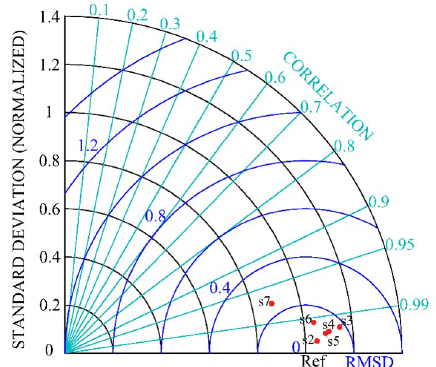
Figure 29. Taylor diagram of hydrodynamic pressures at x = 10m and z = 2 . 1m, taking as reference the data series of the finest reso- lution of dp = 0.1m.